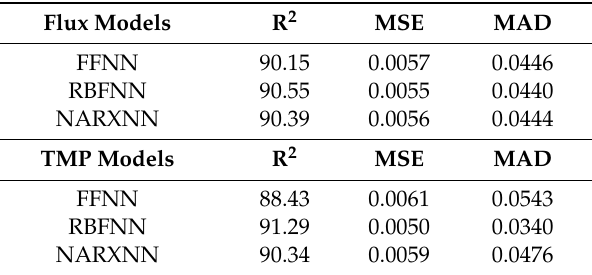
Table 2. Performance evaluation for training results.